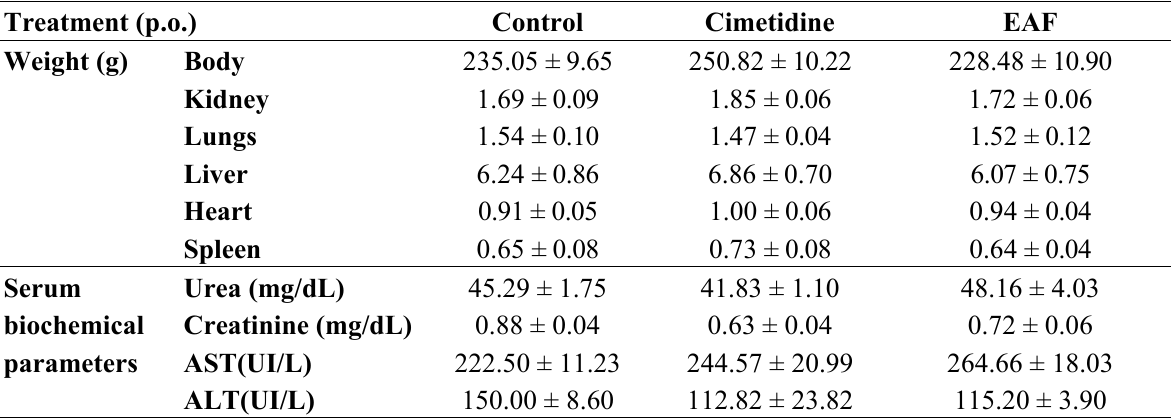
Table 1. Effects on body and organ weights and serum biochemical parameters of a single dose (100 mg/kg, p.o.) of ethyl acetate fraction (EAF) obtained from leaves of Alchornea triplinervia administered for 14 consecutive days after ulcer formation.